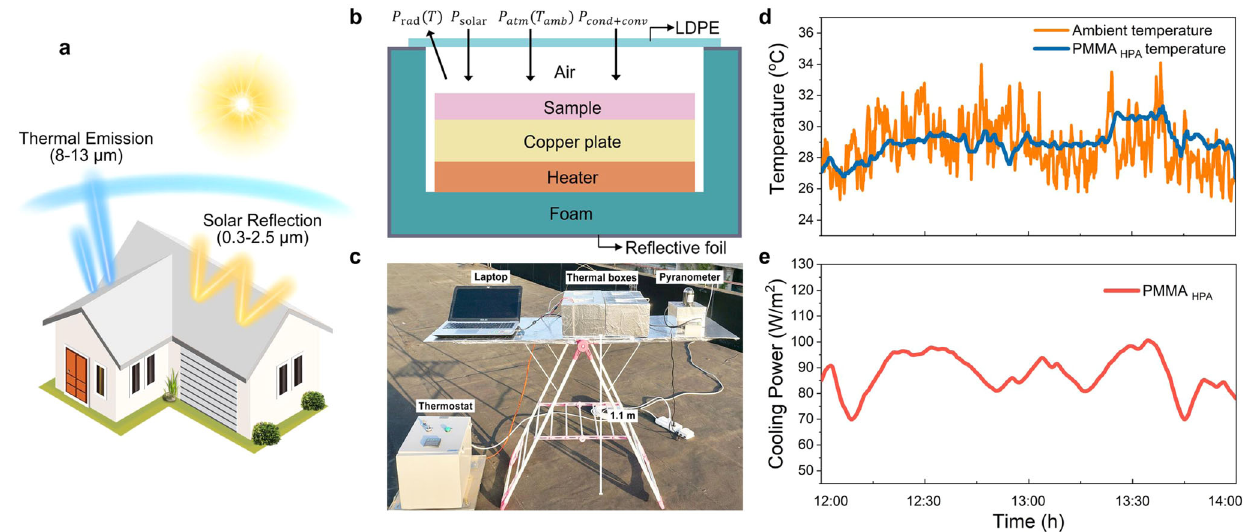
Fig. 7 Net cooling power of the PMMA HPA fi lm during the midday. a Schematic of the basic principles of PDRC. When used in a building roof or external siding, the PMMA HPA fi lm exhibits high solar re fl ectance and high infrared emissivity. b Two-dimensional schematic drawing of the thermal box apparatus with a feedback-controlled heater. The heater maintains the sample surface temperature at that of the ambient environment, minimizing convective and conductive heat losses. c Photo of the experimental apparatus on a rooftop in Shanghai, China. d Temperature tracking of the ambient and the PMMA HPA fi lm under solar intensity of ~ 900 W/m 2 and relative humidity of ~ 44% on April 23, 2020. e Continuous measurement of the radiative cooling power of the PMMA HPA fi lm during the midday.